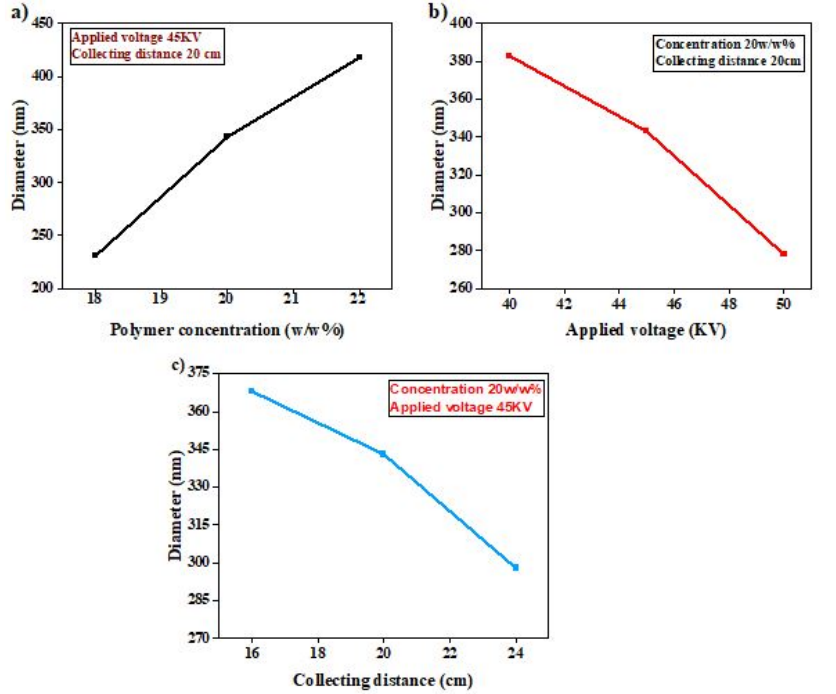
Figure 8. Relationship of nanofibers diameter, polymer concentration, and collecting distance.